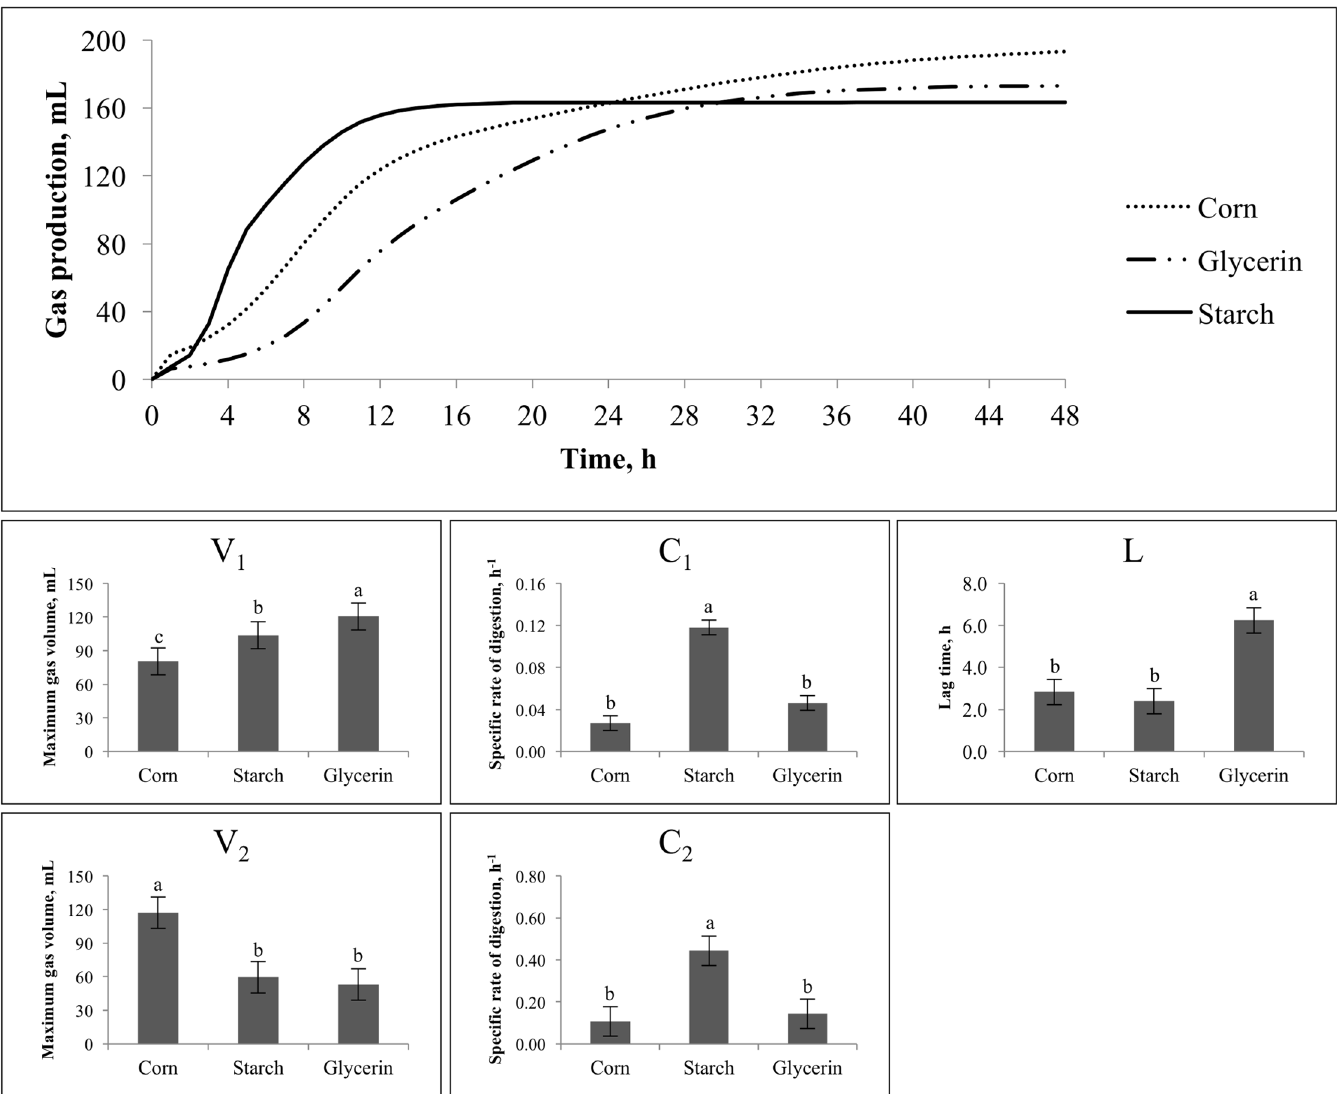
Fig 1. Effects of different ingredients on in vitro gas production and kinetic variables 1 of gas production in Exp. 1. a,b,c Means with different superscripts are different (P < 0.05). 1 V1 and V2 = Maximum gas volume of each pool, mL; C1 and C2 = Specific rate of digestion of each pool, h-1; Lt = lag time, h.